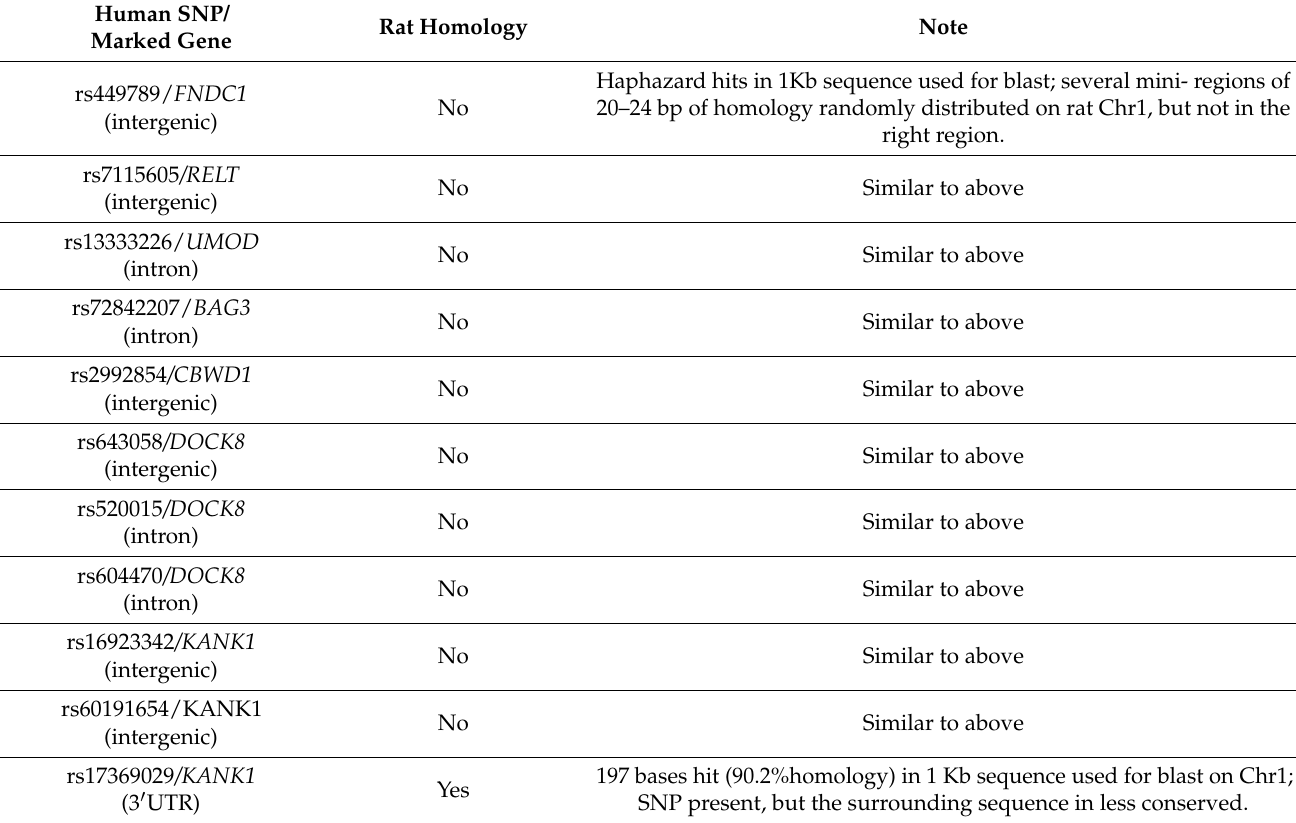
Table 2. A survey of sequence homologies between humans and rats for GWAS